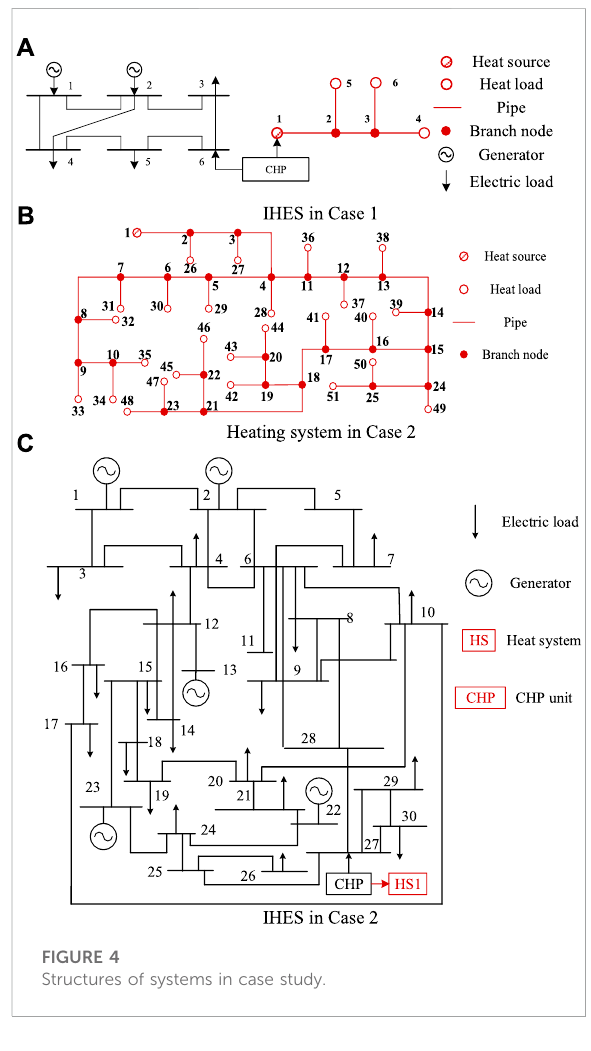
FIGURE 4 Structures of systems in case study.